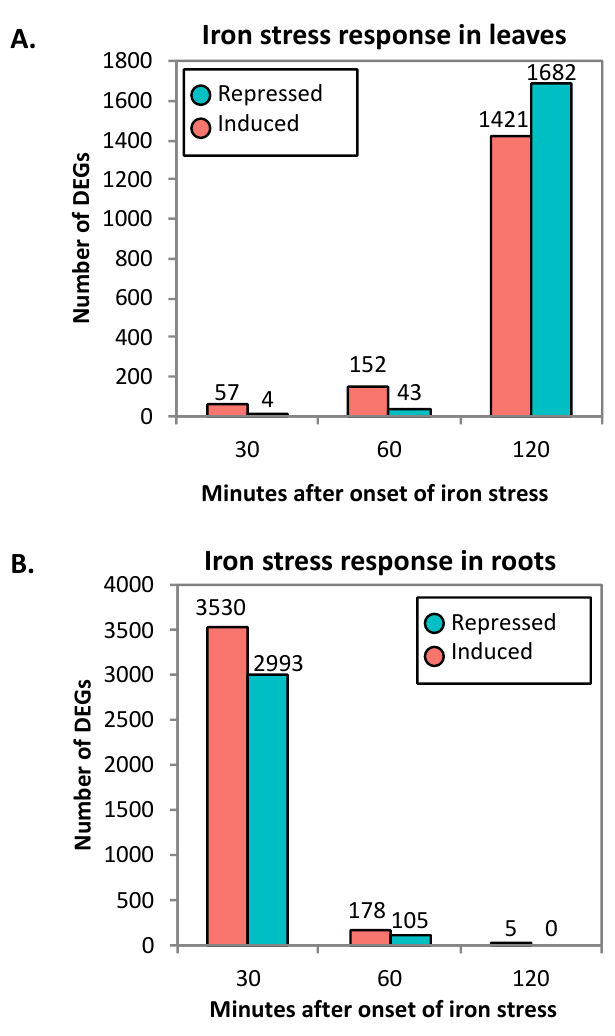
Figure 1. Gene expression changes dramatically in response to iron stress in leaves and roots. Significantly differentially expressed genes (DEGs) (False Discovery Rate (FDR) < 0.01) were identified by comparing gene expression in iron deficient conditions to iron sufficient conditions at each time point. ( A ) Total number of genes induced or repressed at each time point in leaves. ( B ) Total number of genes induced or repressed at each time point in roots. This pattern of increasing number of DEGs over time in the leaves was reversed in roots. In the roots, 3530 out of 6523 DEGs at 30 min, 178 out of 283 DEGs at 60 min, and 5 of 5 DEGs at 120 min were induced by iron stress (Figure 1B, Supplemental Tables S4 – S6). When comparing across time points in leaves, little overlap was observed, with 9 DEGs overlapping between 30 and 120 min and 99 DEGs overlapping between 60 and 120 min. Similarly, in roots 177 DEGs overlapped between 30 and 60 min, 1 DEG was in common between 60 and 120 min, and 2 DEGs were in common between 30 and 120 min. Between leaves and roots, there were 423 DEGs in common. Of these, only seven were significantly differentially expressed at the same time point.